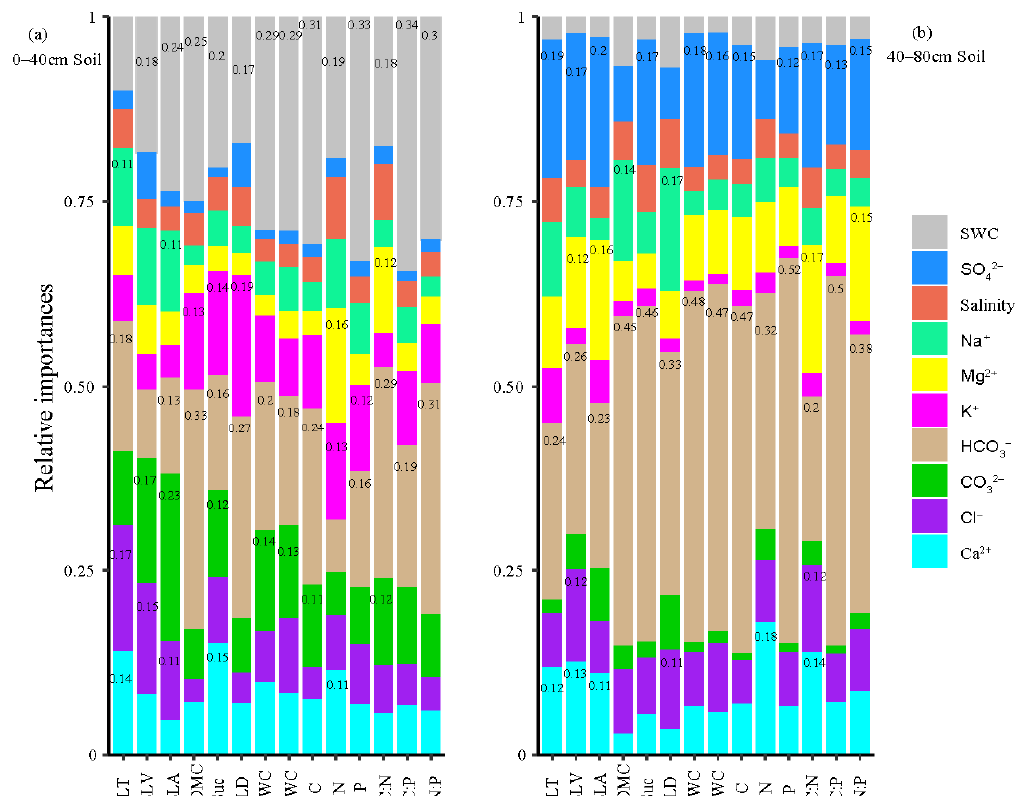
Figure 4. The relative importance of soil factors at two soil depths on leaf functional traits. The horizontal axis is leaf functional traits and the vertical axis is the relative importance of soil factors. SWC: soil water content. The soil factors from top to bottom on the histogram are SWC, SO 42 − , Salinity, Na + , Mg 2+ , K + , HCO 3 − , CO 32 − , Cl − , Ca 2+ . Values below 10% are not shown in Figure 4.